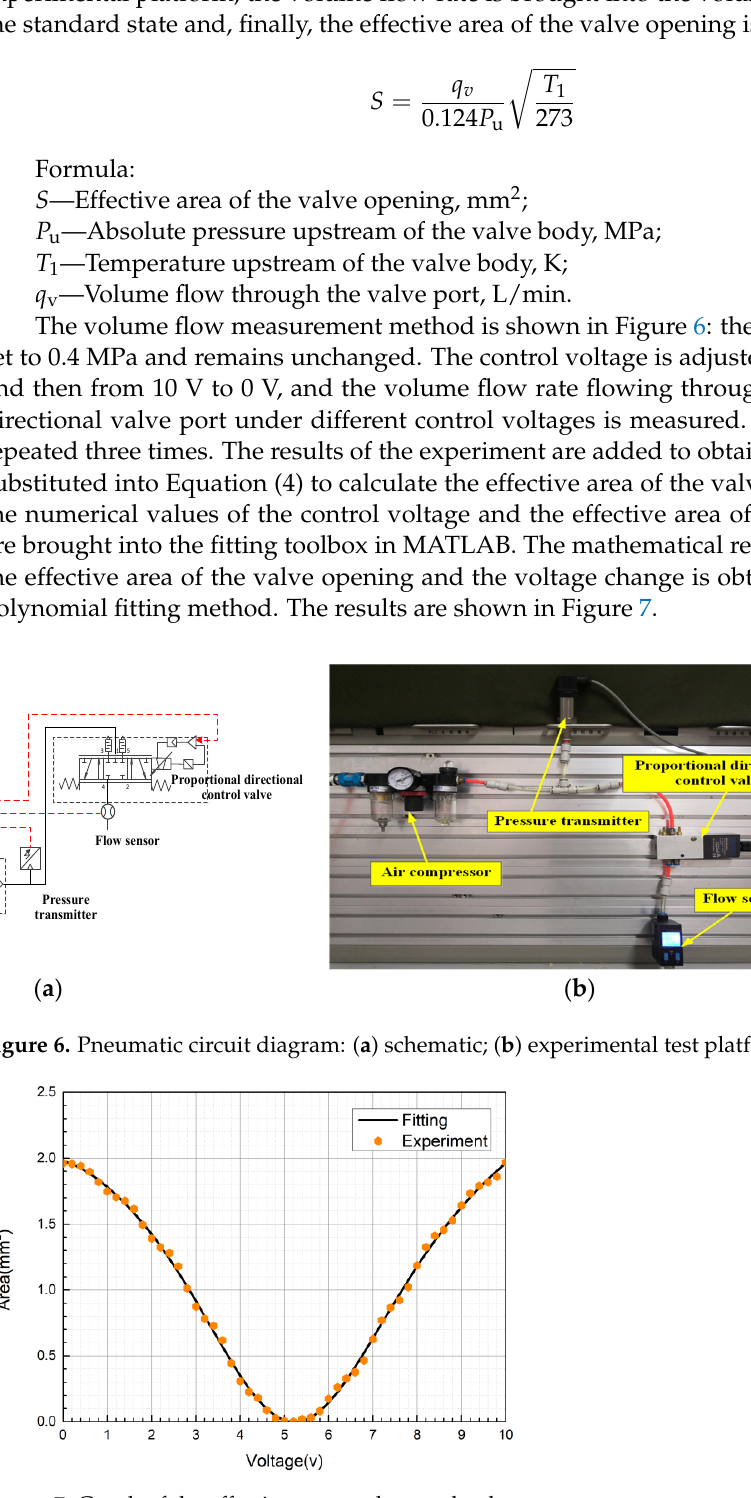
Figure 7. Graph of the effective area and control voltage.